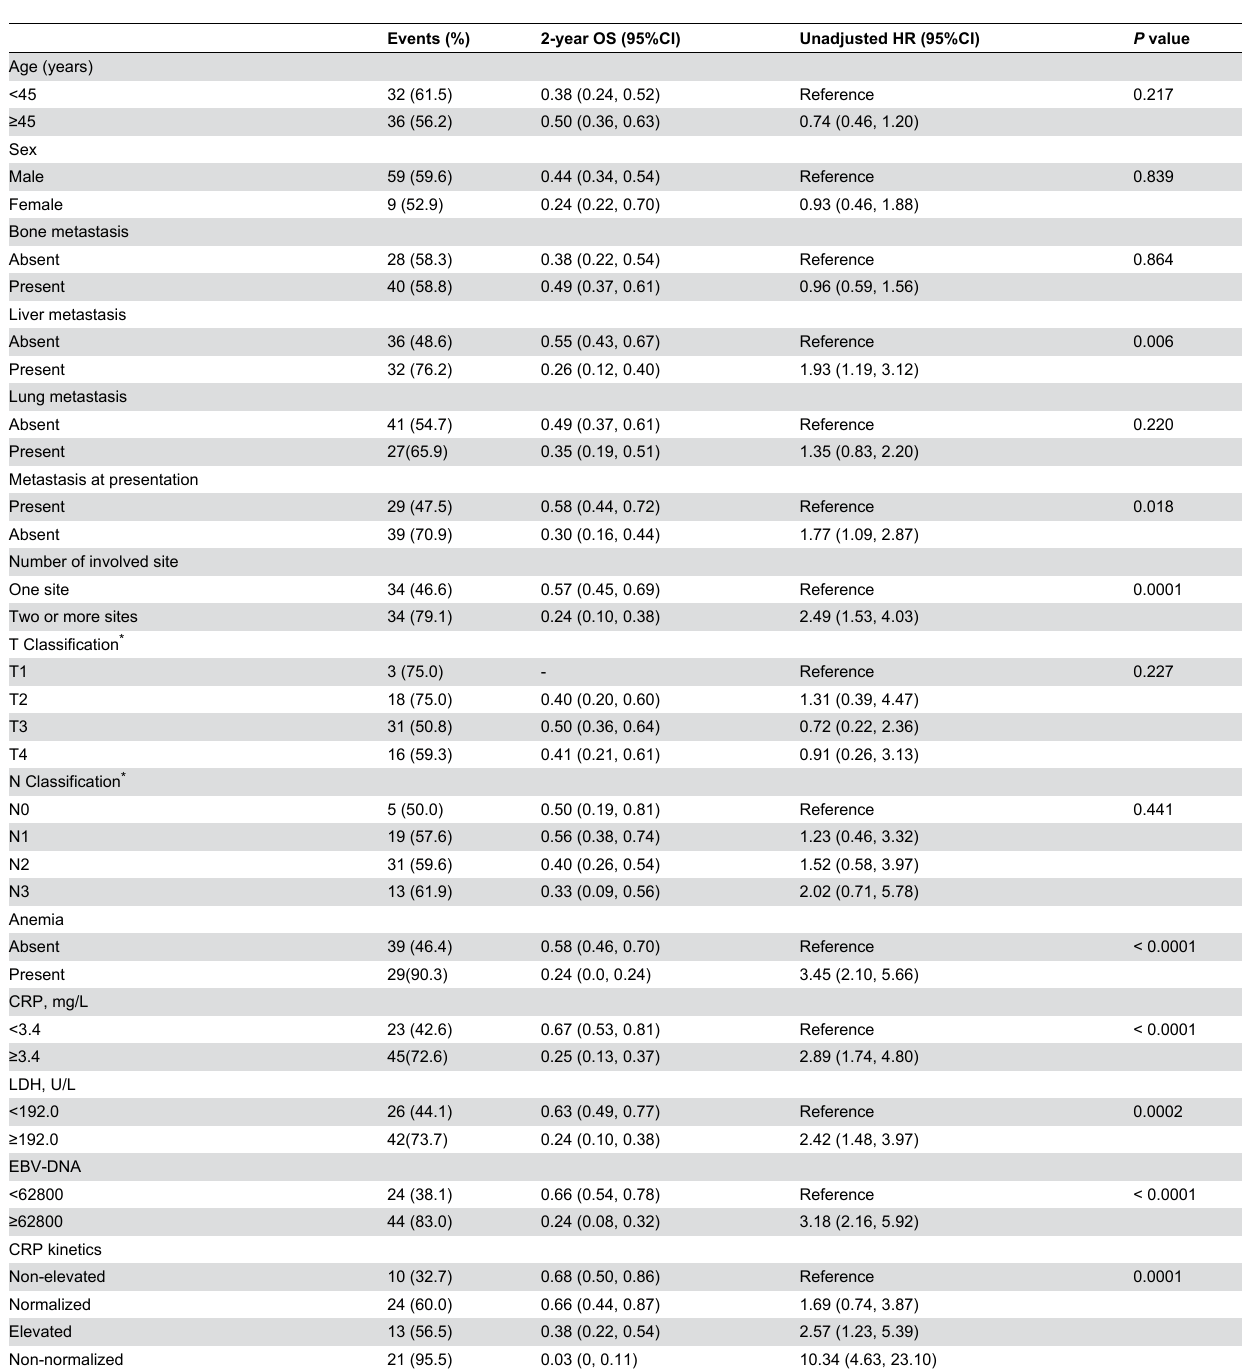
Table 2. Univariate analysis of prognostic factors with overall